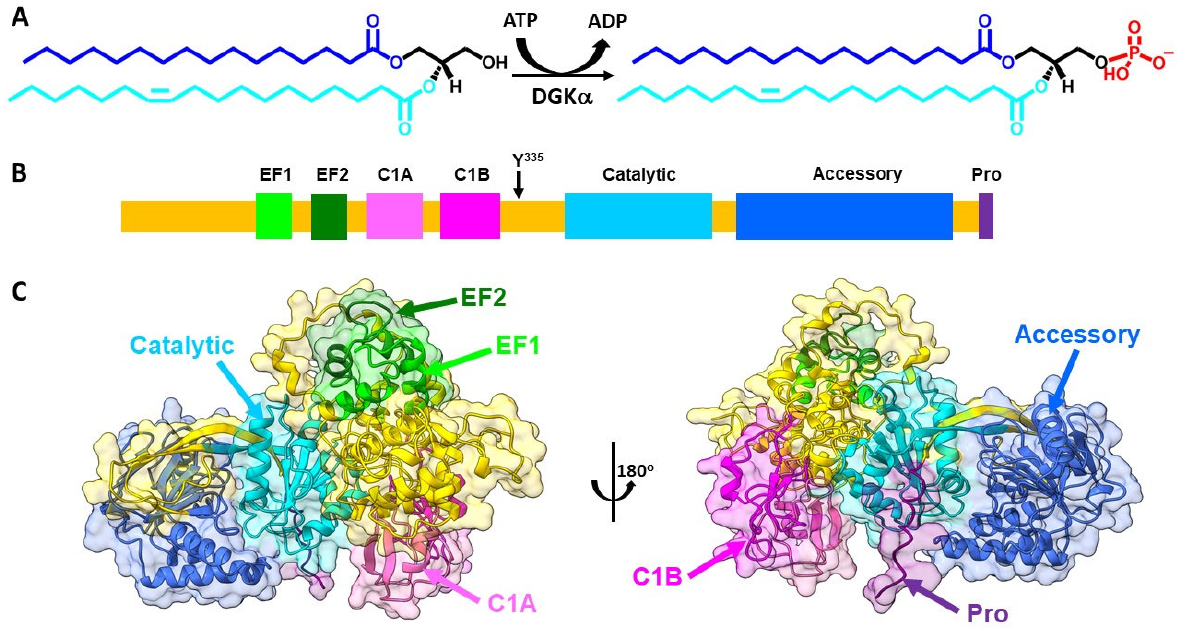
Figure 1. DGK α enzymatic reaction and structure. ( A ) DGK α catalyzes the ATP-dependent phos- phorylation of diacylglycerol (DAG) to produce phosphatidic acid (PA). DAG and PA molecular species bear 16:0 (blue)/18:1 (cyan) acyl chains. This DAG molecular species illustrates an example of DGK α preferred substrate. ( B ) Domain architecture of DGK α includes two EF hand motifs (EF hand 1 in lime and EF hand 2 in forest green), two C1 domains (C1A in hot pink and C1B in magenta), a catalytic domain (dark turquoise), and an accessory domain (royal blue). Y 335 (black arrow), which is involved in DGK α phosphorylation, is identified as well as a proline rich segment (Pro, purple), suggested to be involved in membrane interaction. ( C ) AlphaFold predicted high-resolution structure of human DGK α (UniprotKB accession number P23743) was obtained from AlphaFold database [25]. Structures were generated using Chimera X [26] and domains colored as follows: EF hand 1 (residues 114–142, lime), EF hand 2 (residues 159–187, forest green), C1A (residues 206–253, hot pink), C1B (residues 268–319, magenta), catalytic (residues 376–500, dark turquoise), accessory (residues 520–701, royal blue), and Pro (residues 722–735, purple). The remaining protein was colored in